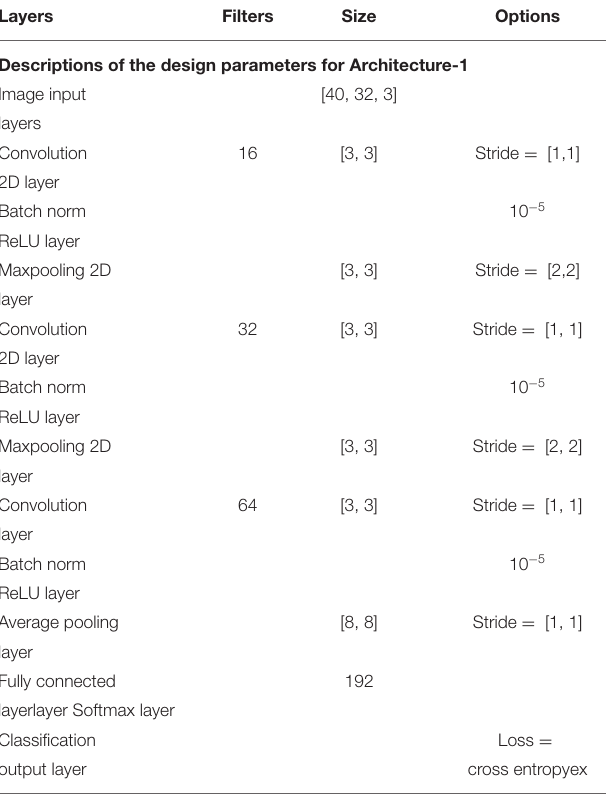
TABLE 1 | Parameters for Architecture-1 for intra-subject learning. Layers Filters Size Options Descriptions of the design parameters for